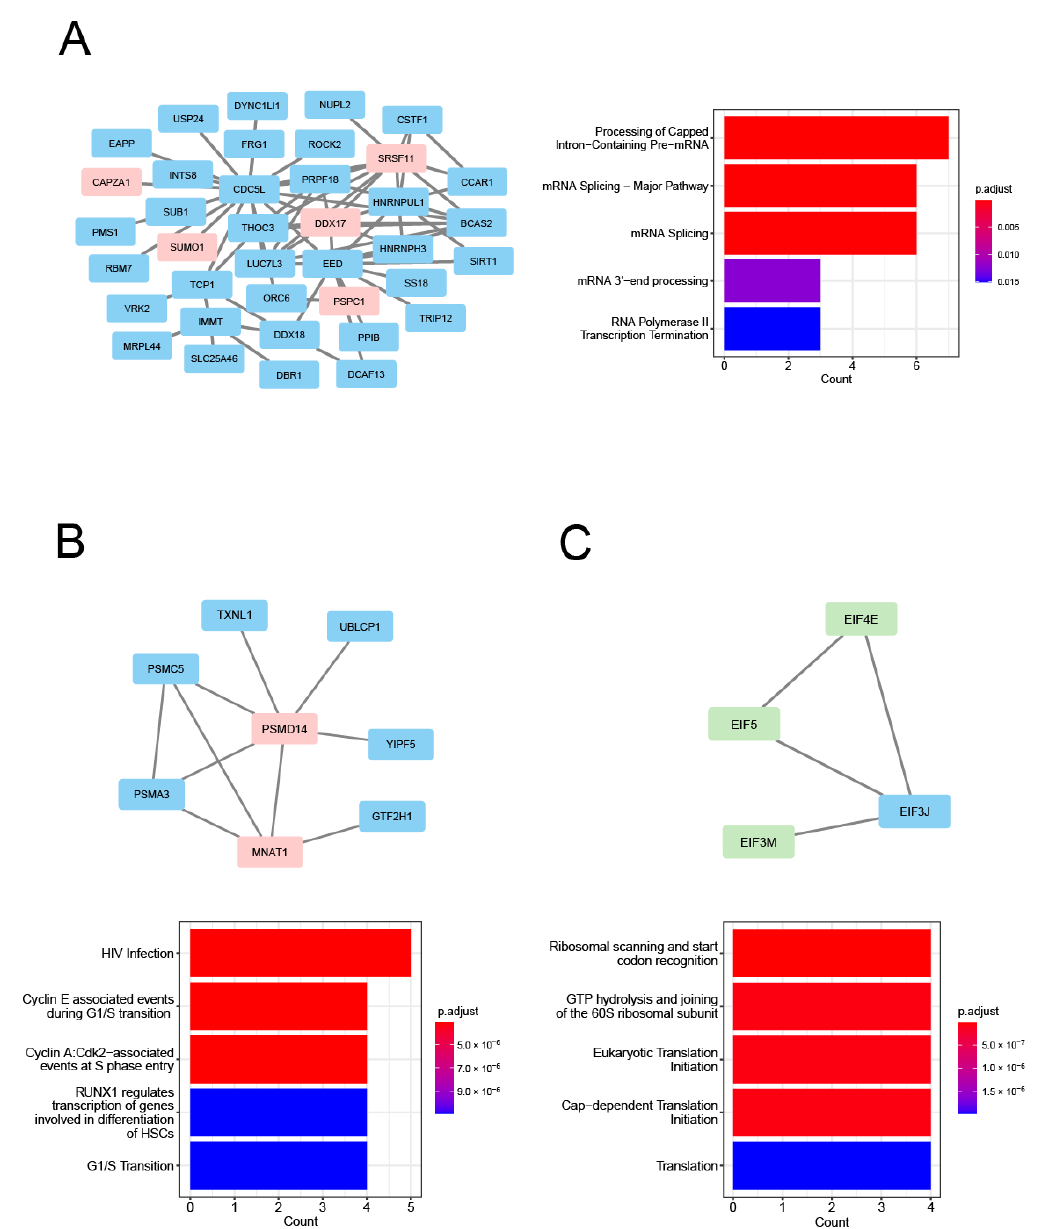
Figure 9. PPI clusters enriched with HAR genes and PS genes: ( A ) The cyan-associated C3 cluster is enriched with PS genes. The functional enrichment analysis (FEA) results of the member genes are shown. ( B ) The cyan-associated C5 cluster is enriched with PS genes. The results of the FEA of the member genes are presented. ( C ) The magenta-associated C6 cluster is enriched with HAR genes. The FEA results are for the member genes. The PS genes are shown in light red and the HAR genes are shown in light green in the network. We used clusterProfiler to determine the reactome pathways for each gene set. The top five reactome pathways are represented by bar plots. The gene count is denoted by the bar ’ s length, and significance is indicated by color. The Benjamini – Hochberg method was used to adjust the p -values.